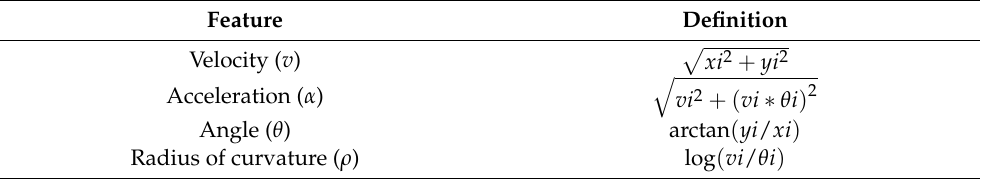
Table 3. Dynamic